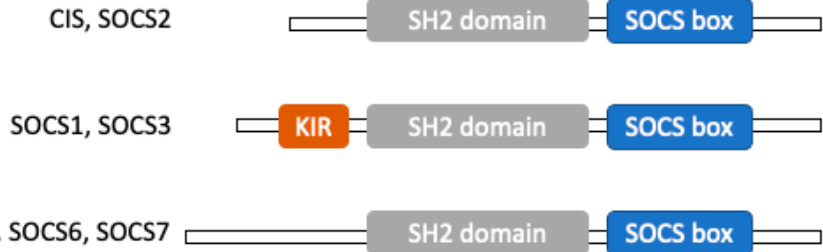
Figure 1. The structure of the SOCS protein. All SOCS family members contain an Src homology 2 (SH2) domain and a segment called the SOCS box located near the C terminal. The SOCS1 and SOCS3 proteins have a unique 12-residue N-terminal kinase inhibitory region (KIR) domain. The KIR domain plays an important role in the interaction with Janus kinase (JAK)/signal transducers and activators of transcription (STAT) pathway. Abbreviation: CIS, cytokine-inducible Src homology 2 domain-containing protein; SOCS, suppressor of cytokine signaling; SH2, Src homology 2; KIR, kinase inhibitory region.